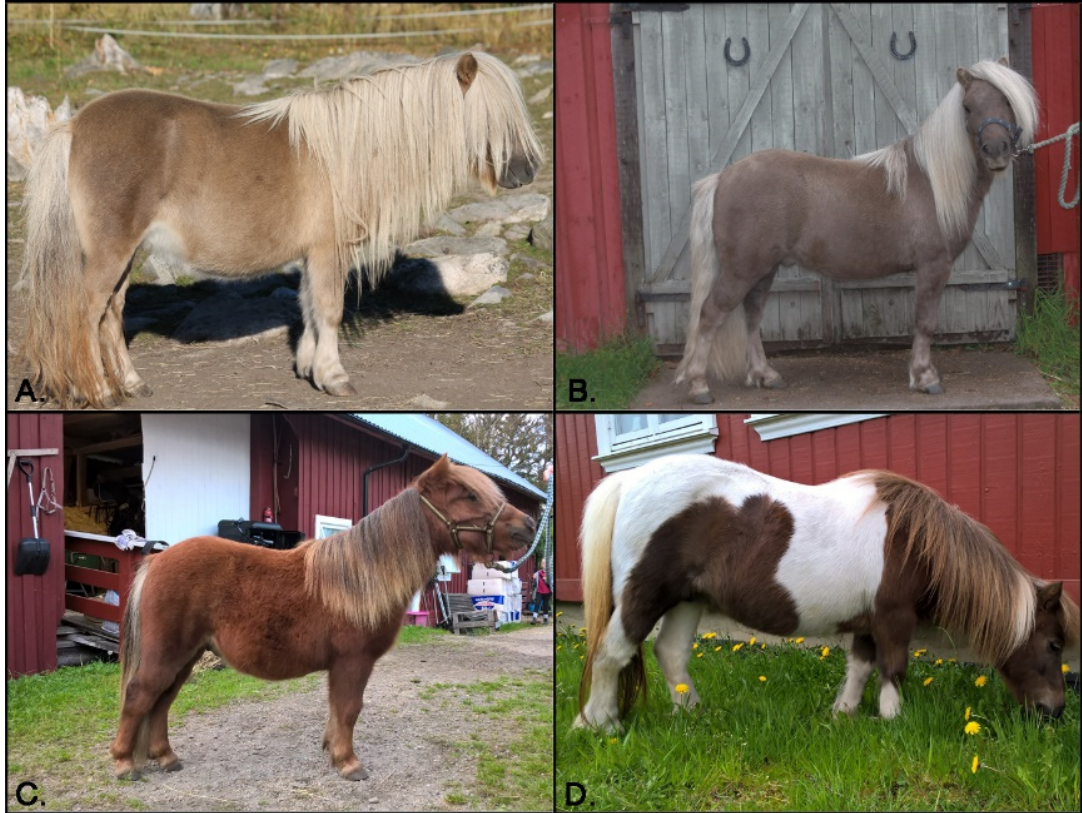
Figure 1. Mushroom and chestnut coat color phenotypes. The mushroom dilution on a chestnut background results in a dilute sepia shade ranging from light ( A ) to dark ( B ) and is often accompanied by a flaxen (lighter) mane and tail. Chestnut Shetland pony without the mushroom dilution displaying a typical red chestnut base coat color ( C ). Chestnut Shetland Pony also showing the tobiano white spotting pattern ( D ). Photo credits ( A ) and ( B ) Maria and Joana Tammi ( C ) and ( D ) Christine Mirjam Sorli.